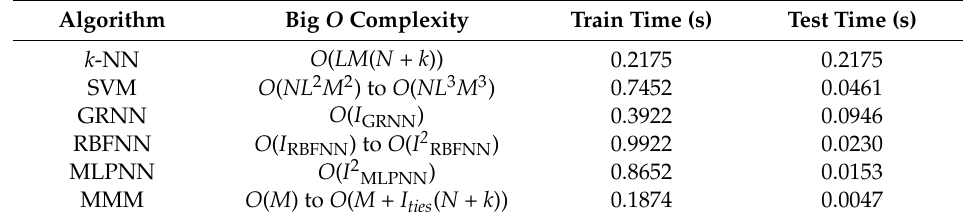
Table 2. Training and testing time taken by the algorithms to train and test with the data samples of banana, sapodilla, and pineapple, each at three ripeness